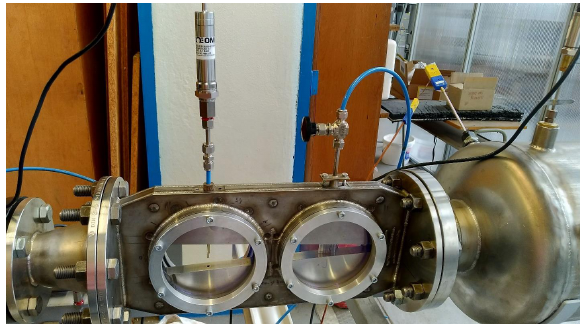
Figure 2. New wind tunnel test section.